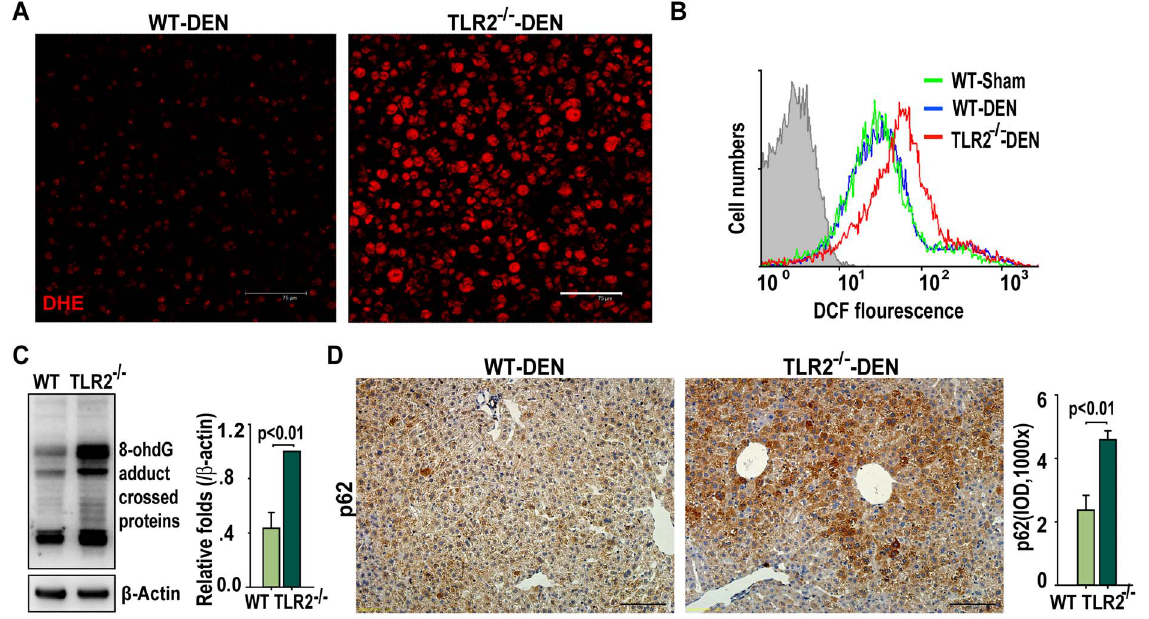
Figure 2. TLR2-deficiency results in increases in ROS accumulation and oxidative DNA damage in DEN-injured liver tissues. (A) Representative images of DHE-detected ROS (left panel, red) in the livers of WT and TLR2 2 / 2 mice at one month post-DEN injection (n=4 per group). Scale bar, 75 m m. (B) DCF fluorescence-detected ROS in livers of WT and TLR2 2 / 2 mice (n=4 per group). (C) Western blot detection of 8- hydroxyguanosine adduct crossed proteins in livers of WT and TLR2 2 / 2 mice at one month post-DEN injection. Data are presented as mean 6 SEM (n=4 per group). (D) Representative images of p62 immunostaining in livers of WT and TLR2 2 / 2 mice at one month post-DEN injection (left panel). Scale bars, 100 m m. The p62 intensities are presented as mean 6 SD (n=4 per group, right panel).